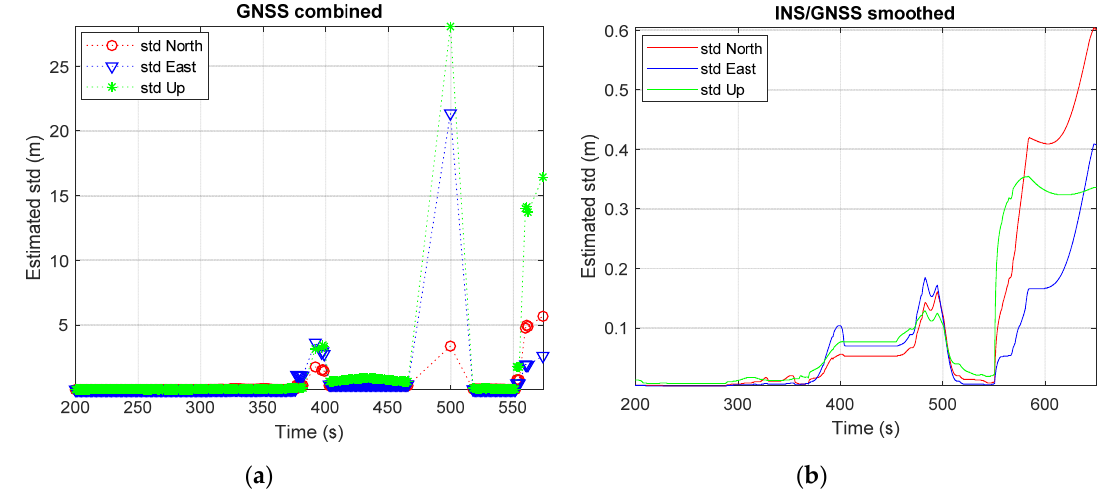
Figure 9. Estimated std from the second test: ( a ) GNSS-only solution; ( b ) INS/GNSS integration with smoothing solution.